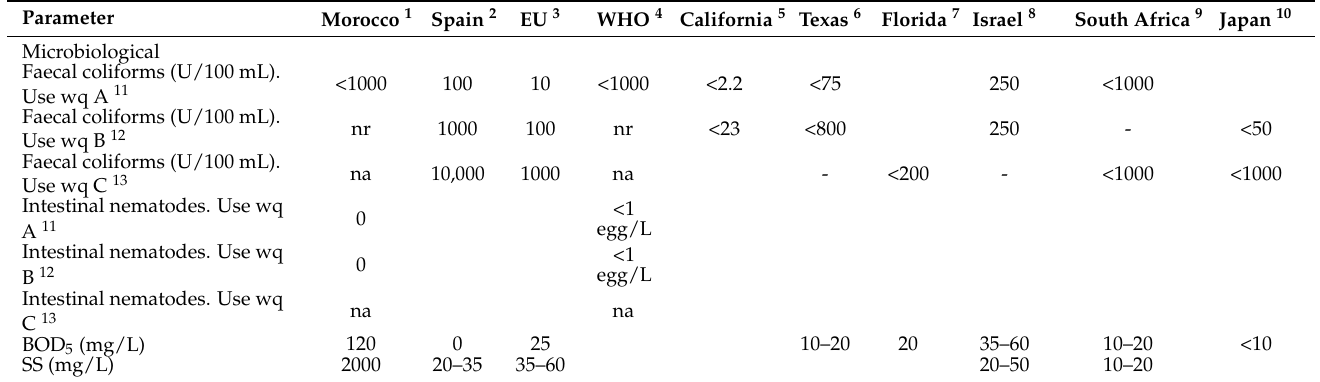
Table 3. Some quality standards of the Moroccan and other selected countries’ regulations for treated wastewater reuse for irrigation